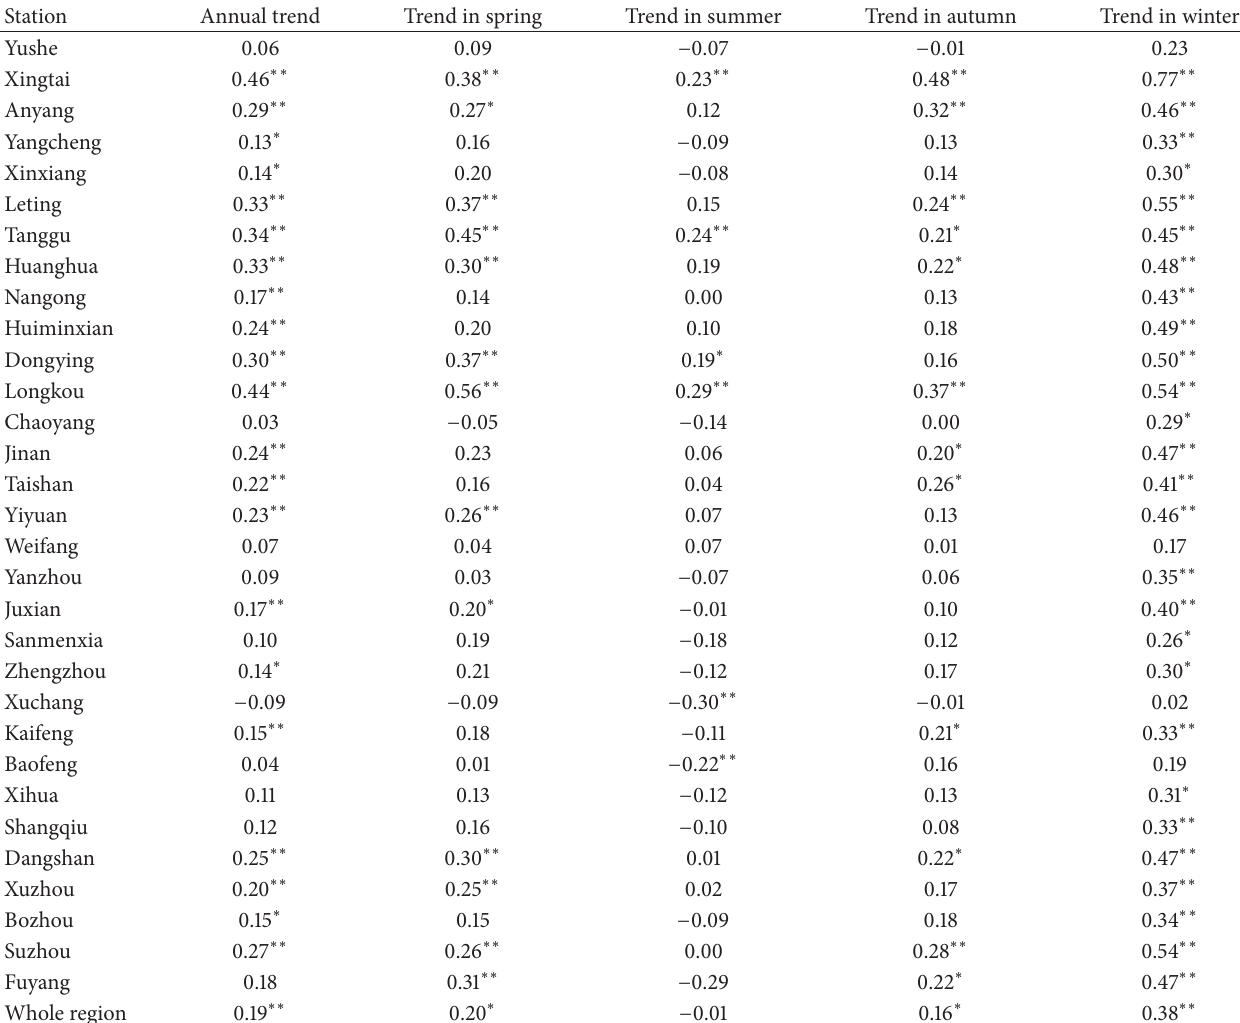
Table 1: Annual temperature trend, temperature trend in spring, temperature trend in summer, temperature trend in autumn, temperature trend in winter, and their significances.